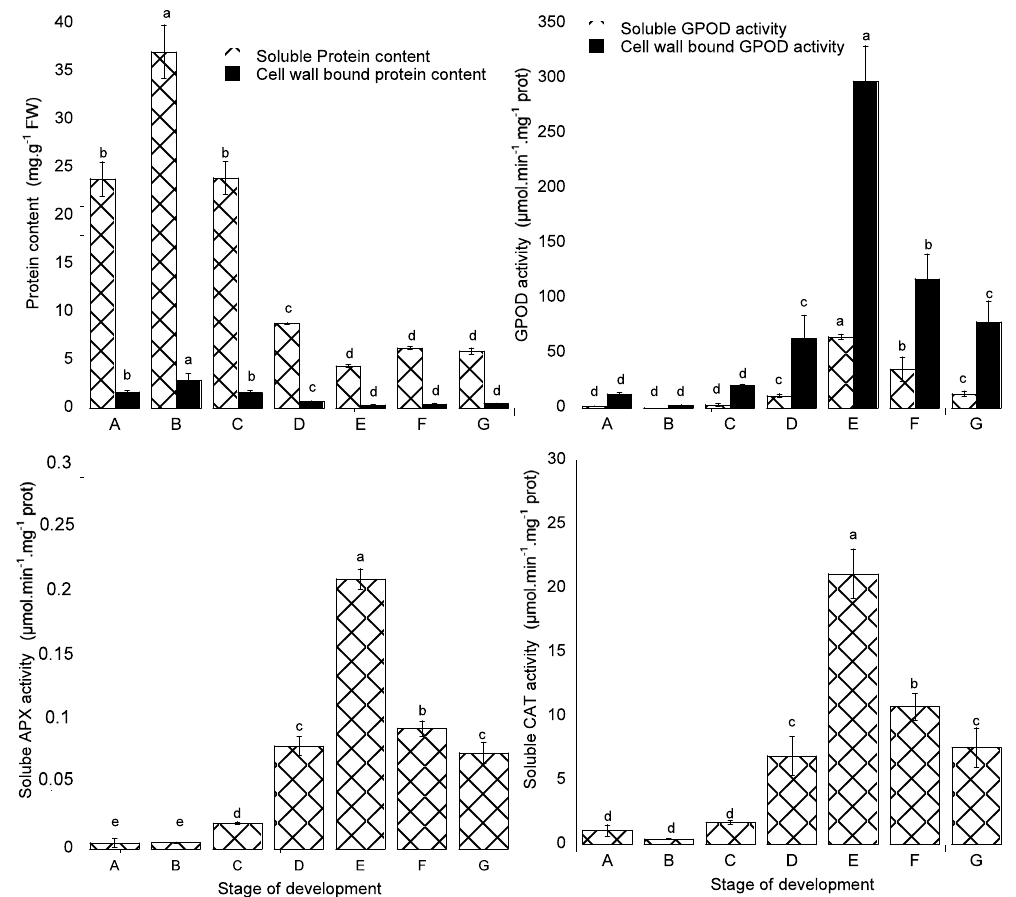
Fig. 3: Changes in protein (soluble and CWB) content and H 2 O 2 scavenging enzyme specific activities in floral buds during flower development in lemon trees. Stages of development are described in Fig. 2. Bars indicate the standard error (mean+/- S.E.,